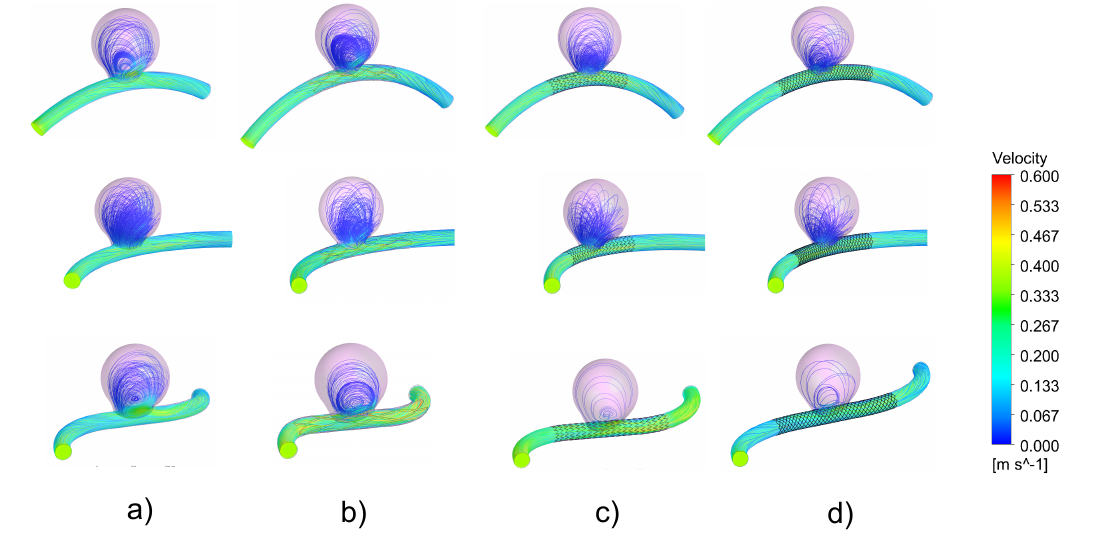
Figure 2. Streamlines introduced at the inlet of each model, colored with the local velocity magnitude, plotted at the peak flow during systole for the same vascular geometry and for the three flow diverter stents considered in this study: ( a ) no stent, ( b ) STENT 1, ( c ) STENT 2 and ( d ) STENT